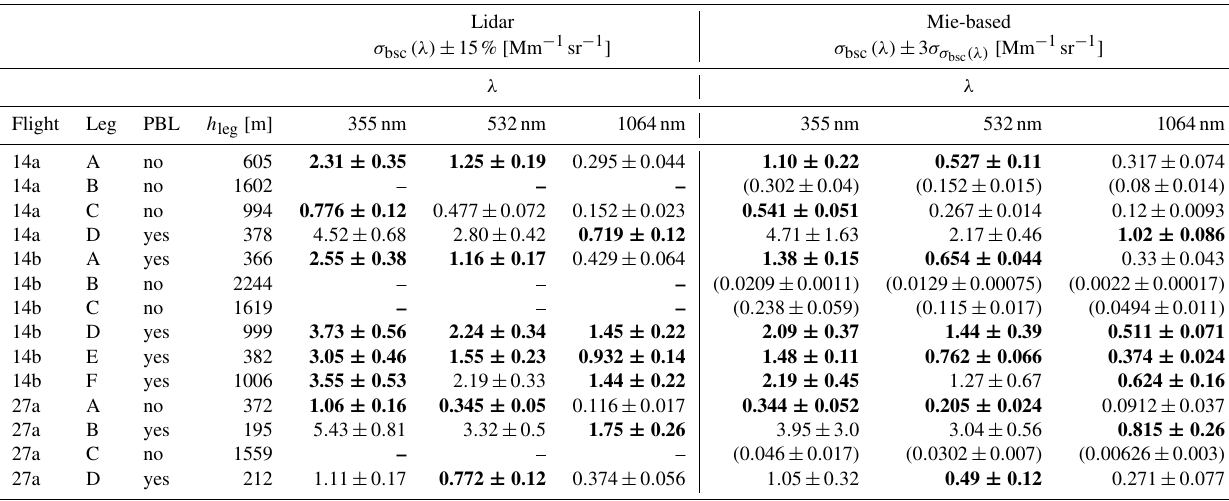
Table B1. Table shows the aerosol particle light backscatter coefficient ( σ bsc ) derived with the lidar for the wavelengths 355, 532, and 1064nm for the mean height of each investigated leg. Also, the aerosol particle light backscatter coefficient converted from the airborne in situ aerosol measurements is printed for the respective lidar wavelength and horizontal leg. Additionally, it is shown whether the horizontal flight leg was conducted within or above the PBL. Values written in bold represent a disagreement between lidar and model, while normal script is an agreement. Brackets around the values indicate no lidar measurements available.